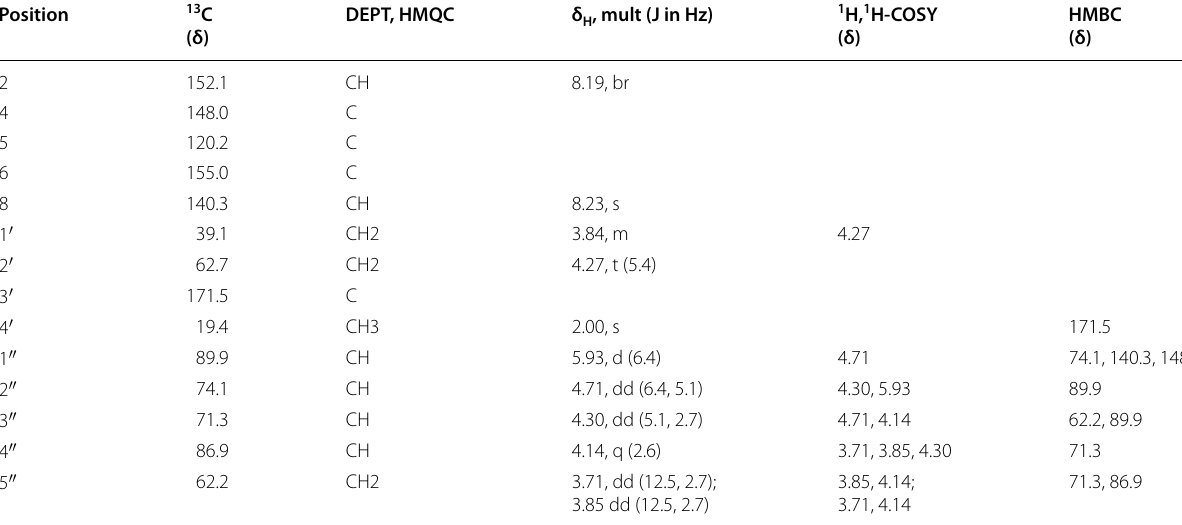
Table 2 1D and 2D NMR spectral data (δ in ppm) of compound 5